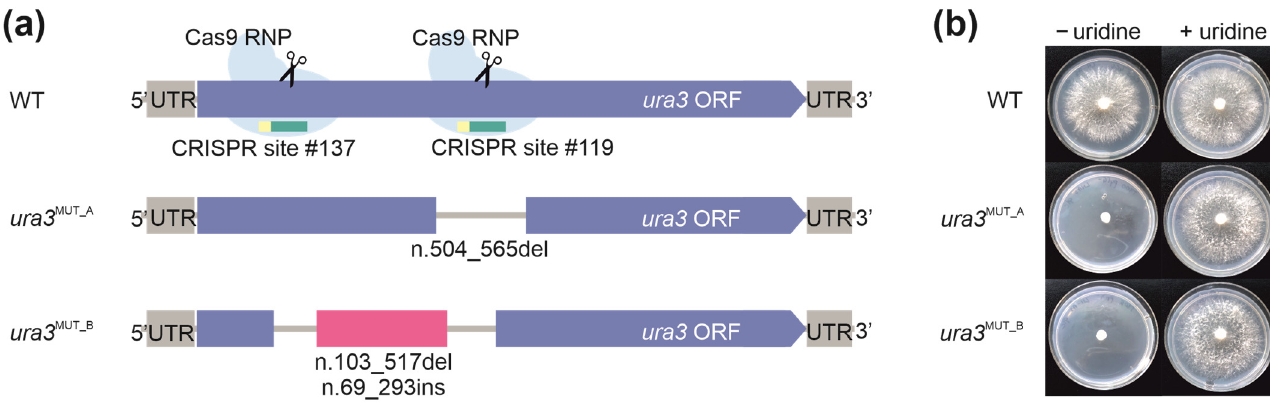
Figure 2. CRISPR/Cas9 RNPs were used for targeted mutagenesis of the ura3 gene, encoding orotidine 5 ′ -phosphate decarboxylase, in the wild-type D. squalens strain (WT): ( a ) schematic representation of the Cas9 target sites in the WT ura3 gene and mutations introduced by NHEJ to ura3 MUT_A and ura3 MUT_B strains and ( b ) the ura3 mutants have defects in the pyrimidine biosynthesis pathway and require exogenous uridine supplementation.